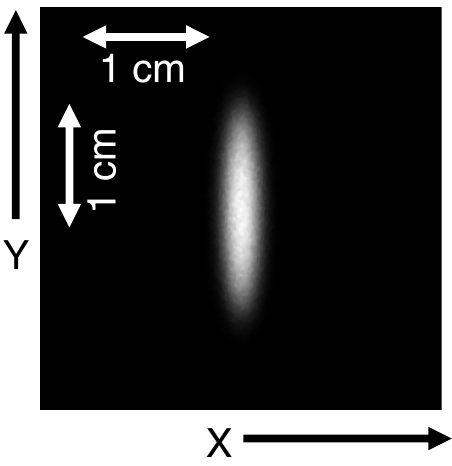
FIG. 9. Spatial distribution of the 7 mA electron beam starting with a hollow velocity